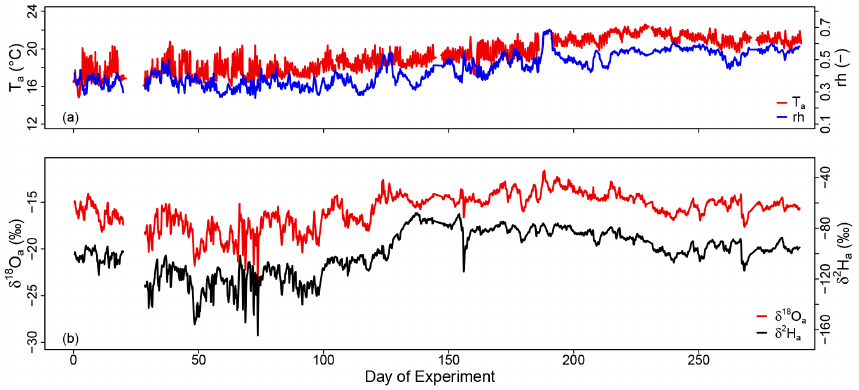
Figure 3. Time series of the laboratory ambient air temperature ( T a ), relative humidity (RH), and water vapor isotope compositions ( δ 18 O a and δ 2 H a [‰ VSMOW]) over the course of the